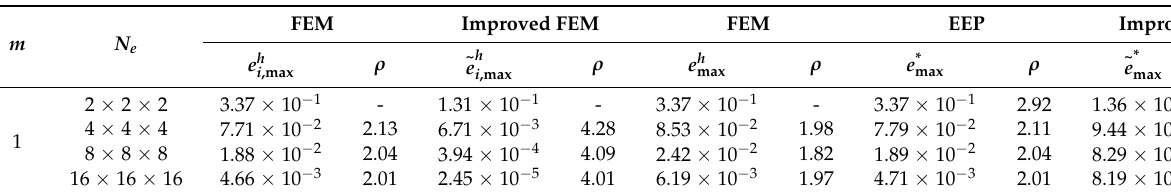
Table 4. Convergence orders of displacements.